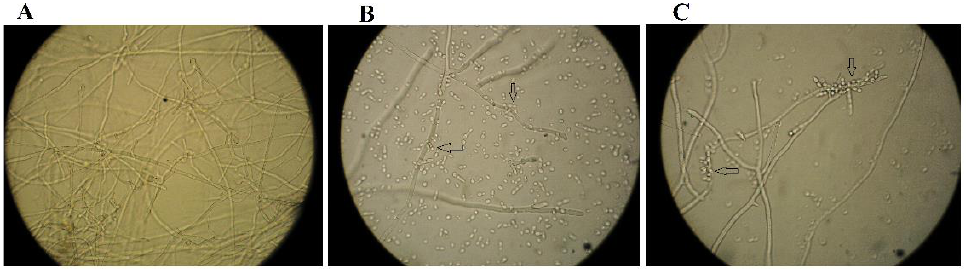
( A ) — A. flavus as a control; ( B ) — A. pullulans PP4 with A. flavus; and ( C ) — A. pullulans ZD1 with A. flavus . Arrows indicate the accumulation of yeast cells at the mycelium of A. flavus .